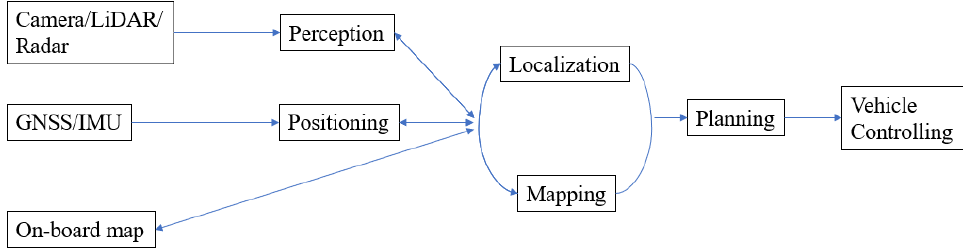
Figure 1. Functional components of an autonomous driving system.